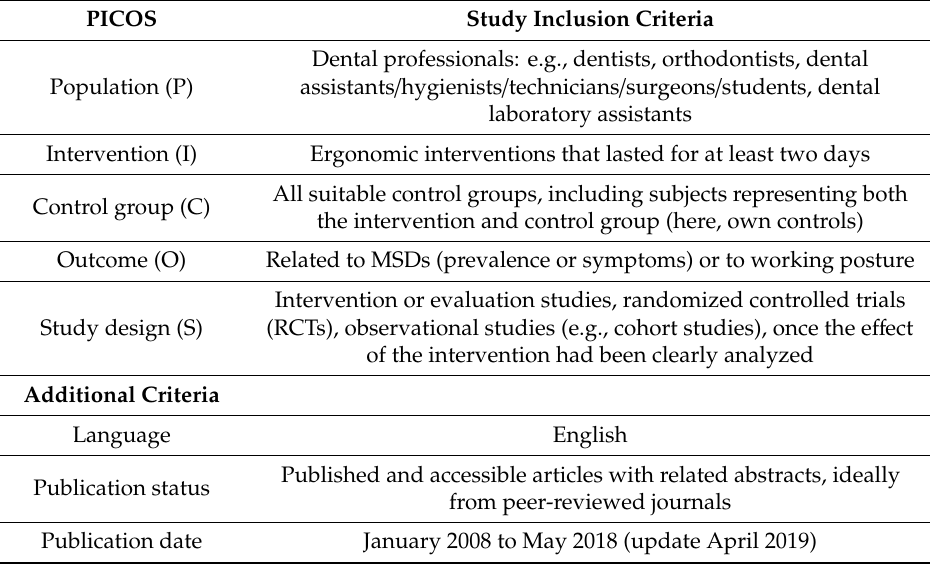
Table 1. Eligibility criteria for the study